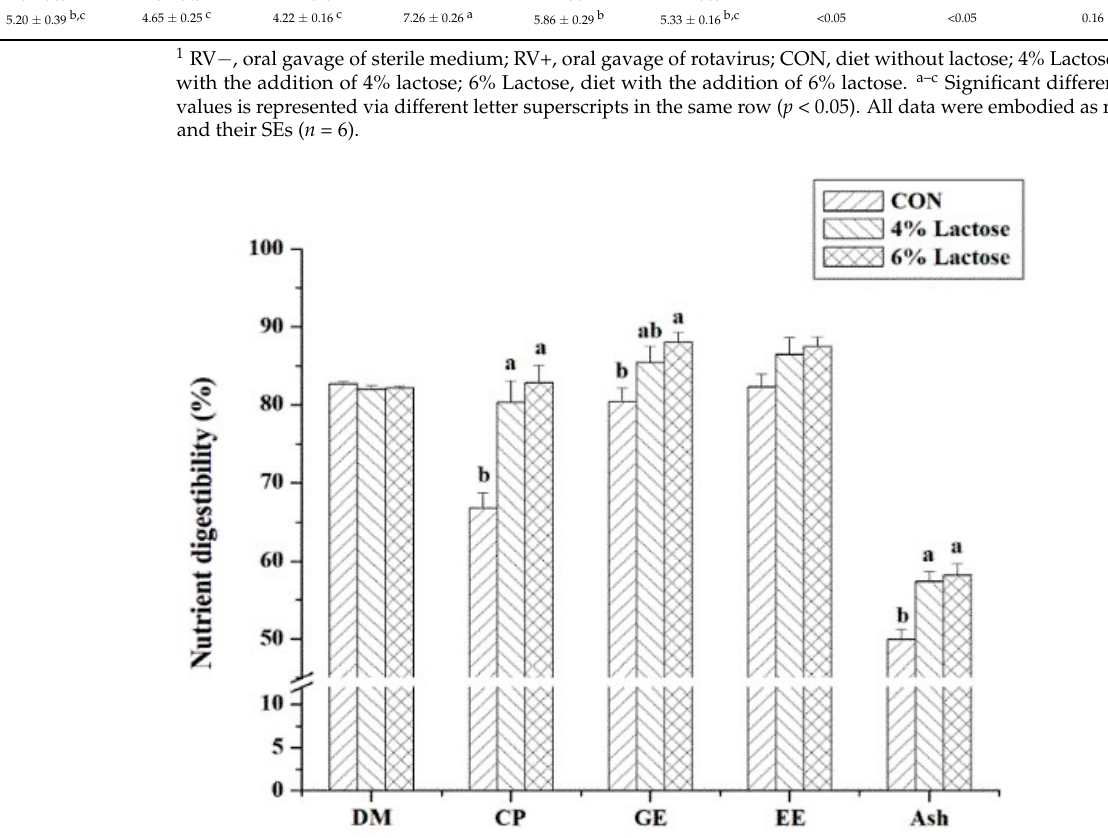
Table 5. Effect of dietary lactose supplementation and/or RV challenge on diarrhea status in weaned pigs 1 .